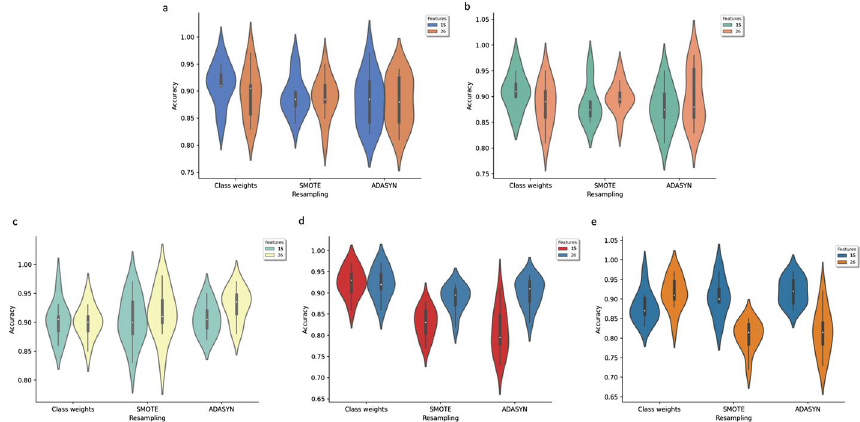
Fig. 2 Violin plots showing the distribution of accuracy estimates obtained across the cross‑validation folds during model training of five algorithms using three class imbalance correction methods—( a ) Logistic regression ( b ) Linear SVM ( c ) Radial basis function SVM ( d ) Random Forest ( e ) Decision tree